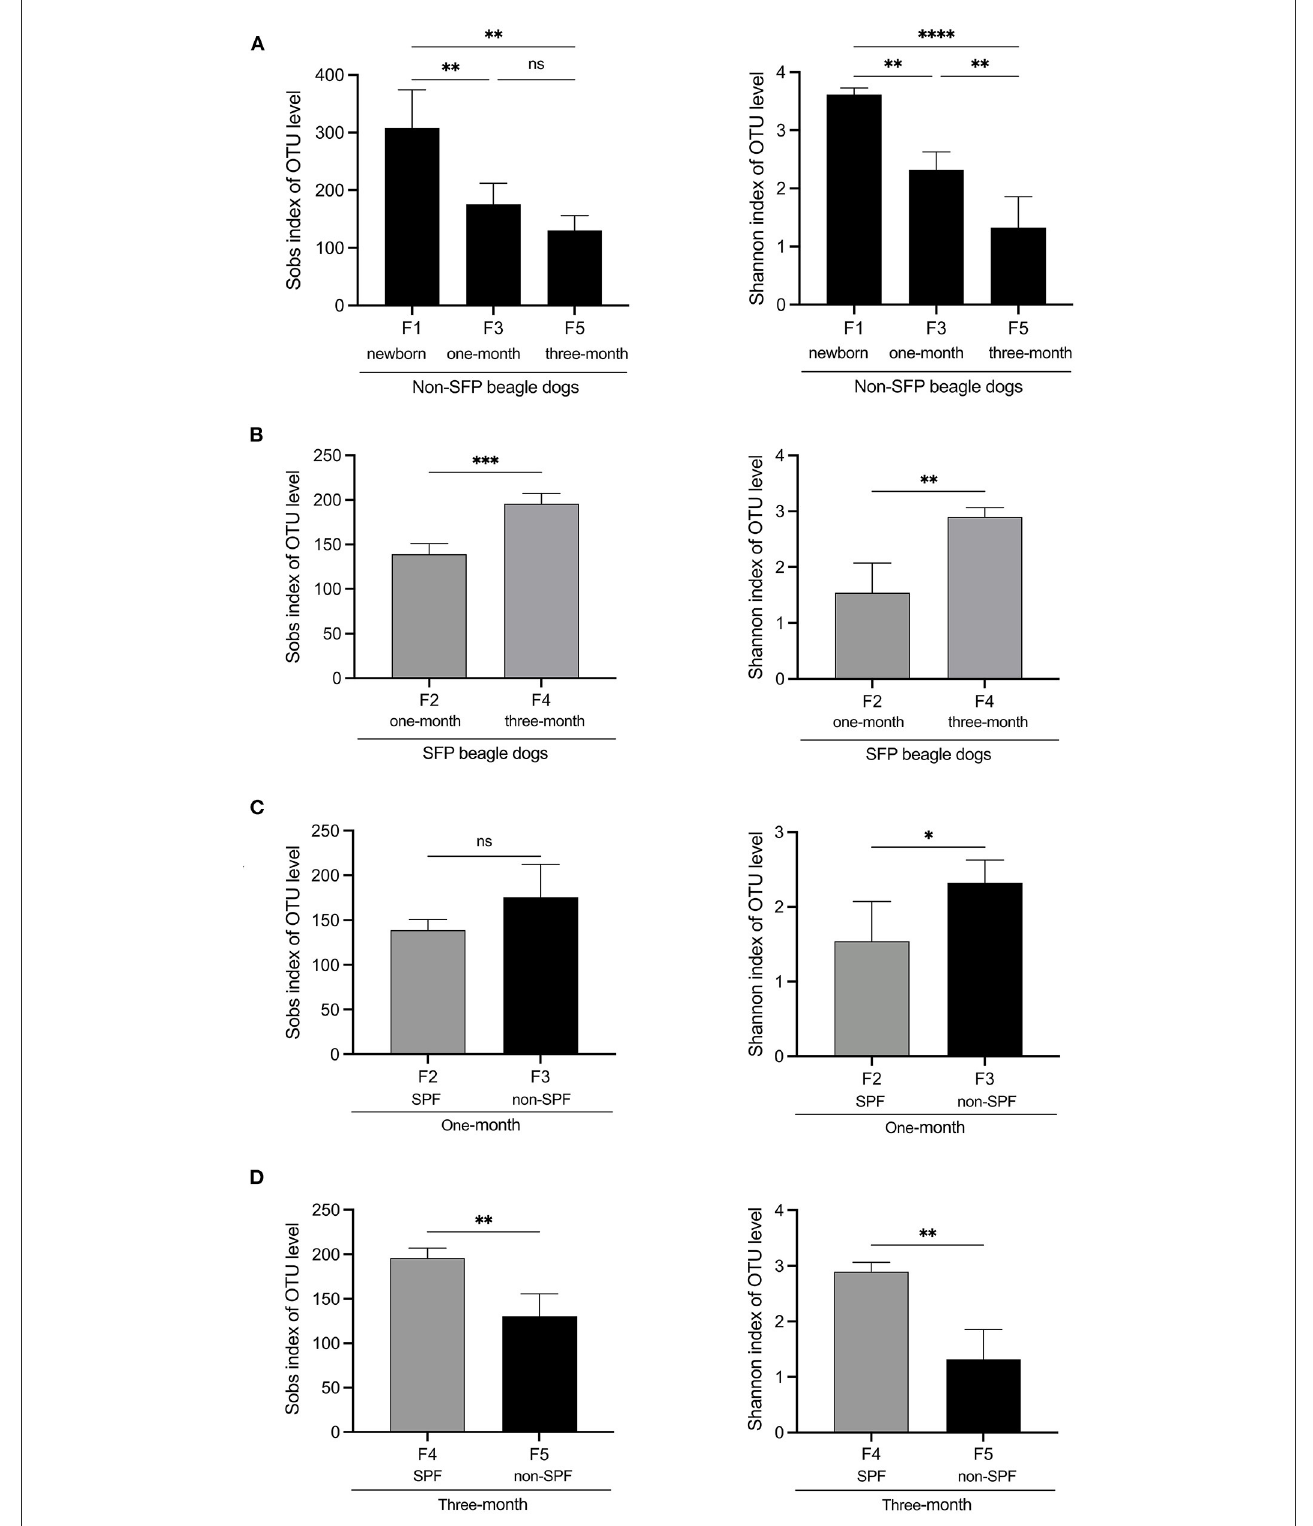
FIGURE1 Alpha diversity comparisons of fecal microbiota of non-SPF and SPF beagles. (A) Sobs and Shannon species richness indices for the samples of F1 (newborn[[Inline Image]]), F3 (1-month-old) and F5 (3-month-old) groups in non-SPF Beagle dogs. (B) Sobs and Shannon species richness indices for the samples of F2 (1-month-old) and F4 (3-month-old) groups in SPF Beagle dogs. (C) Sobs and Shannon species richness indices for 1-month-old non-SPF (F3) and SPF (F2) Beagle dogs. (D) Sobs and Shannon species richness indices for 3-month-old non-SPF (F5) and SPF (F4) Beagle dogs. The data represent the means ± the SD of four independent samples. Statistical analyses were performed by ANOVA, using GraphPad Prism software (* P < 0.05; ** P < 0.01; *** P < 0.001; **** P < 0.0001; “ns” indicates no statistical